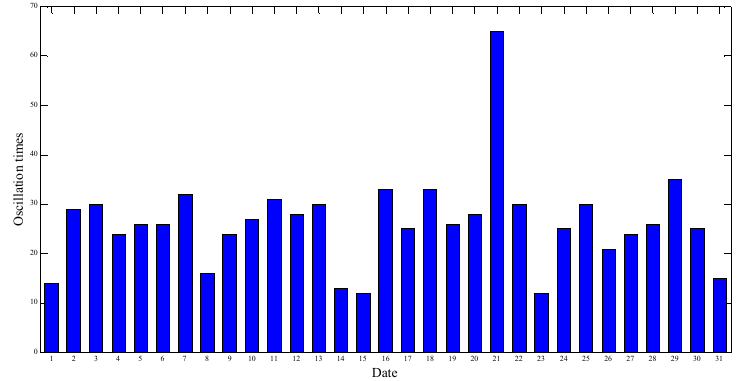
Figure 1. The distribution of oscillation times of the UHV tie line oscillations in January 2015.